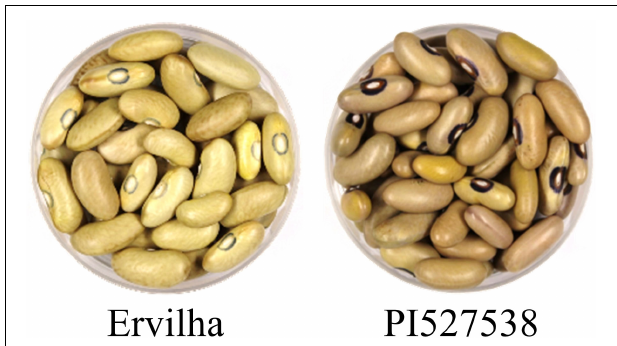
FIGURE 1 | Images of Ervilha and PI527538 raw